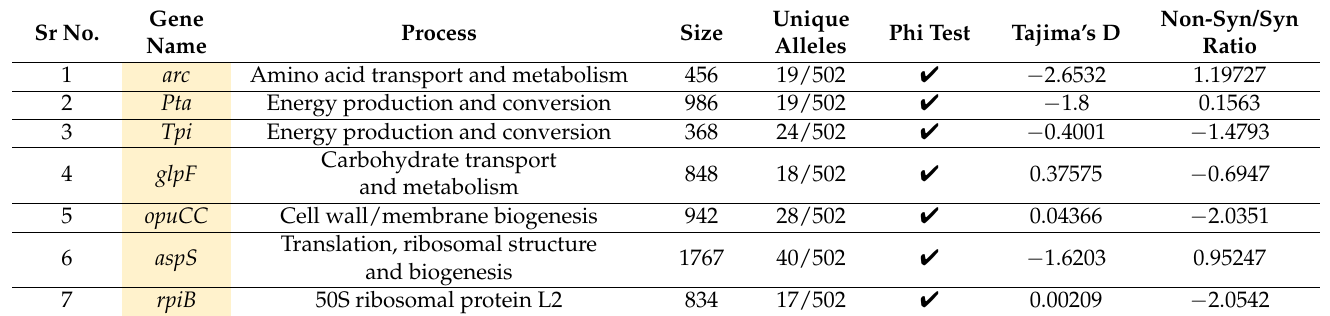
Table 6. Proposed MLST scheme. The table represents the MLST scheme that is based on old and newly proposed candidate